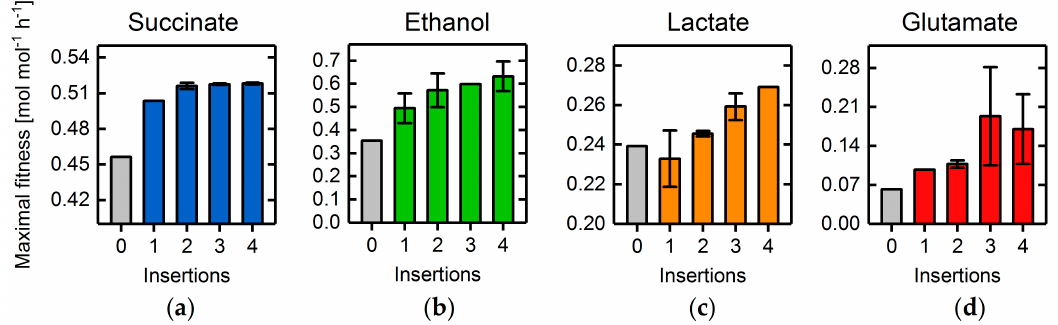
Figure 12. Fitness of the best individual after 1800 generations. BPCY of succinate ( a ), ethanol ( b ), lactate ( c ), and glutamate ( d ) was used as the engineering objective while applying five reaction deletions, as well as one to four novel reaction insertions. The grey bars illustrate the fitness of the best individual after 900 generations without considering any reaction additions (cf. Figure 8).